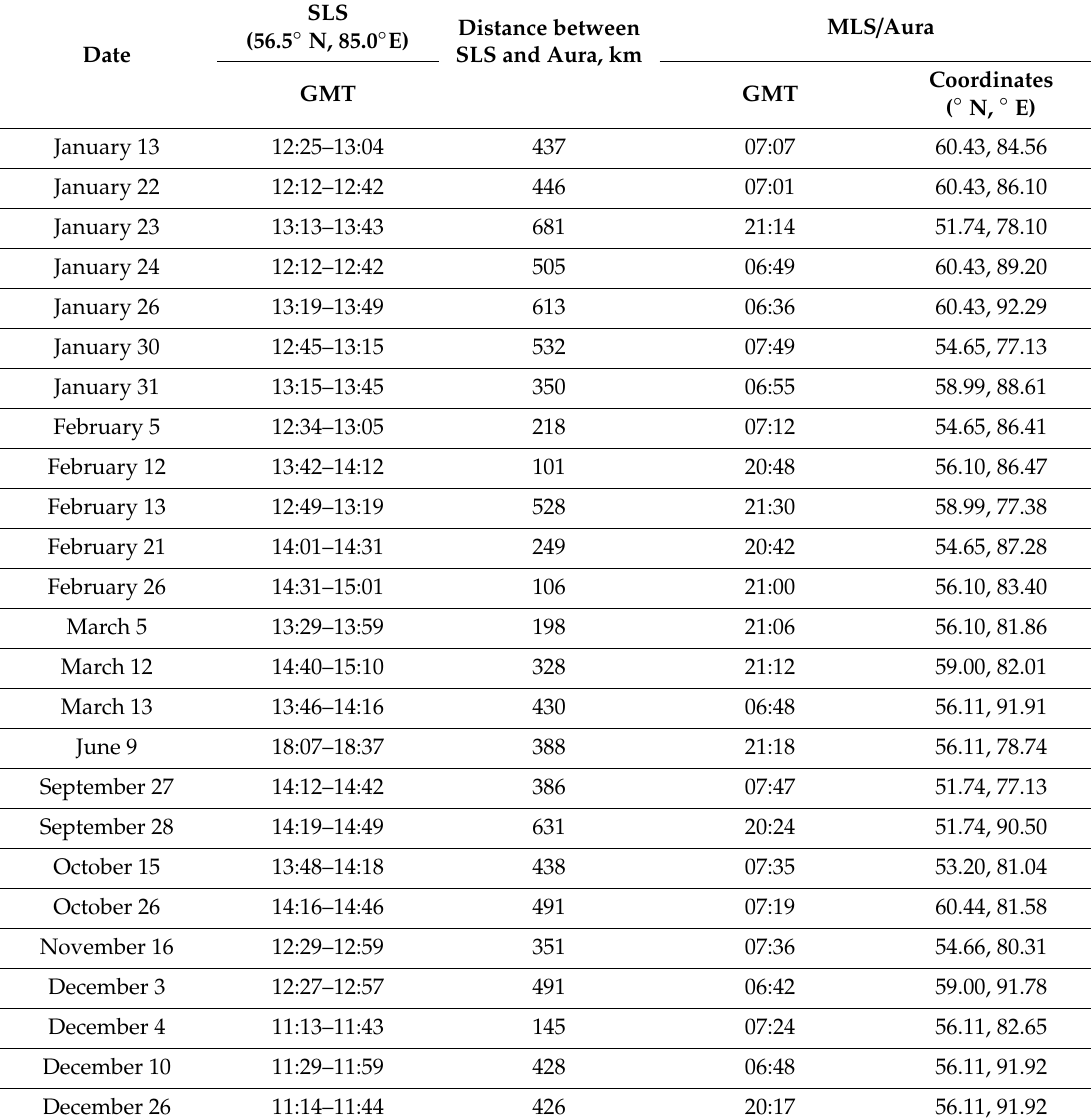
Table 2. Coordinates and time of MLS / Aura and lidar sounding used for the comparison of OVD in 2018.